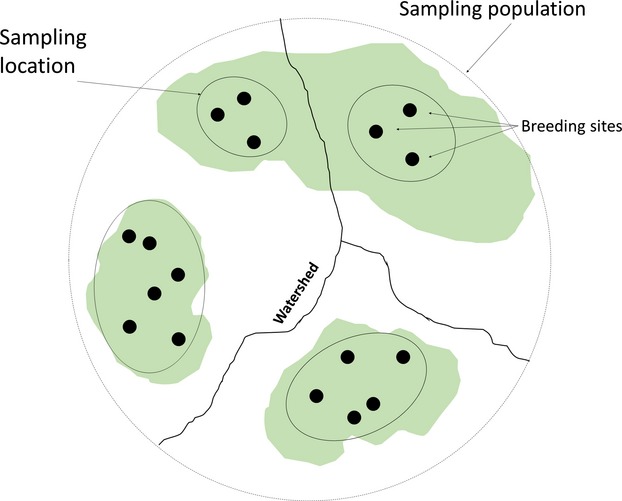
Sampling design of Fire Salamander larvae. Each sampling population (dotted circle) can contain a variable number of sampling locations (continuous-line ovals), which group all breeding sites (black dots) in the same continuous forest patch (green areas) and in the same watershed (black lines).